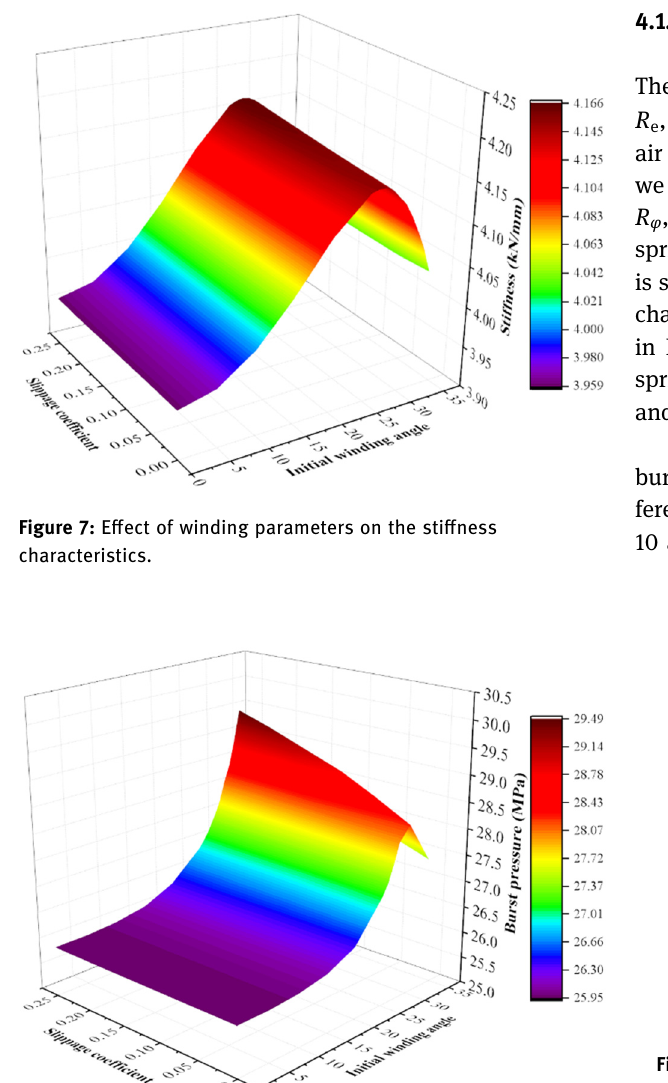
Figure 9: E ff ect of the ripple radius on the sti ff ness and burst pressure.